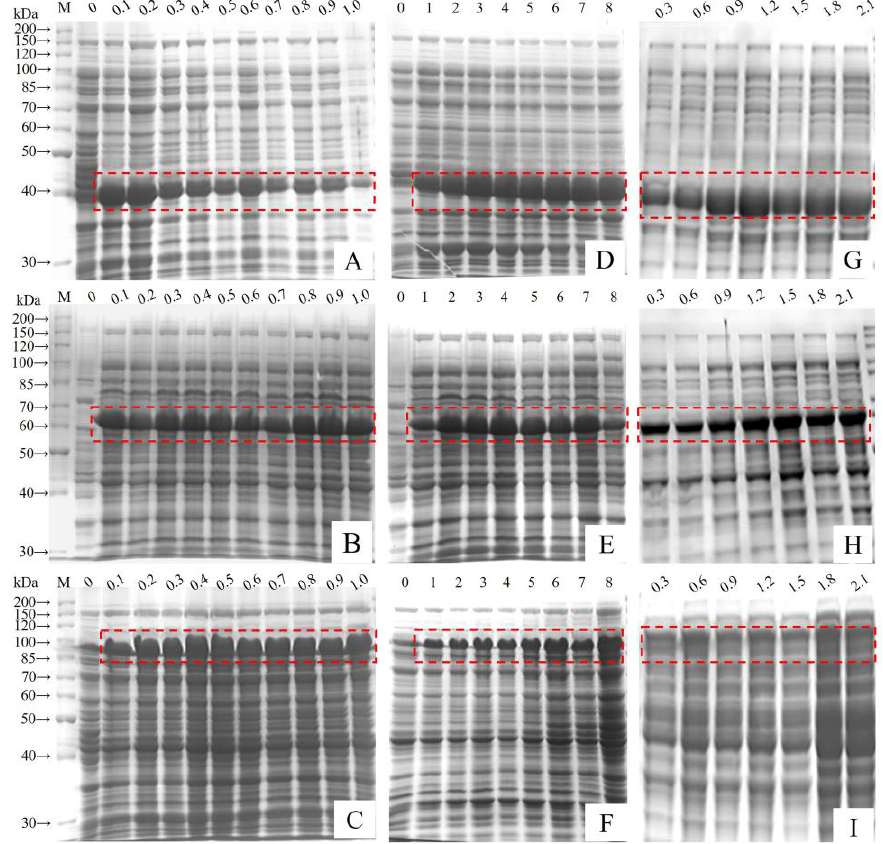
Figure 4. SDS-PAGE electrophoretogram of E. coli BL21 total proteins under different expression conditions. ( A – C ) different IPTG concentration (mM); ( E , F ) different induce time (h); ( G – I ): different initial cell density (OD 600 ). ( A,D,G ): GST-GS16F1; ( B,E,H ): GST-GS16F4; and ( C,F,I ): GST-GS16F8.